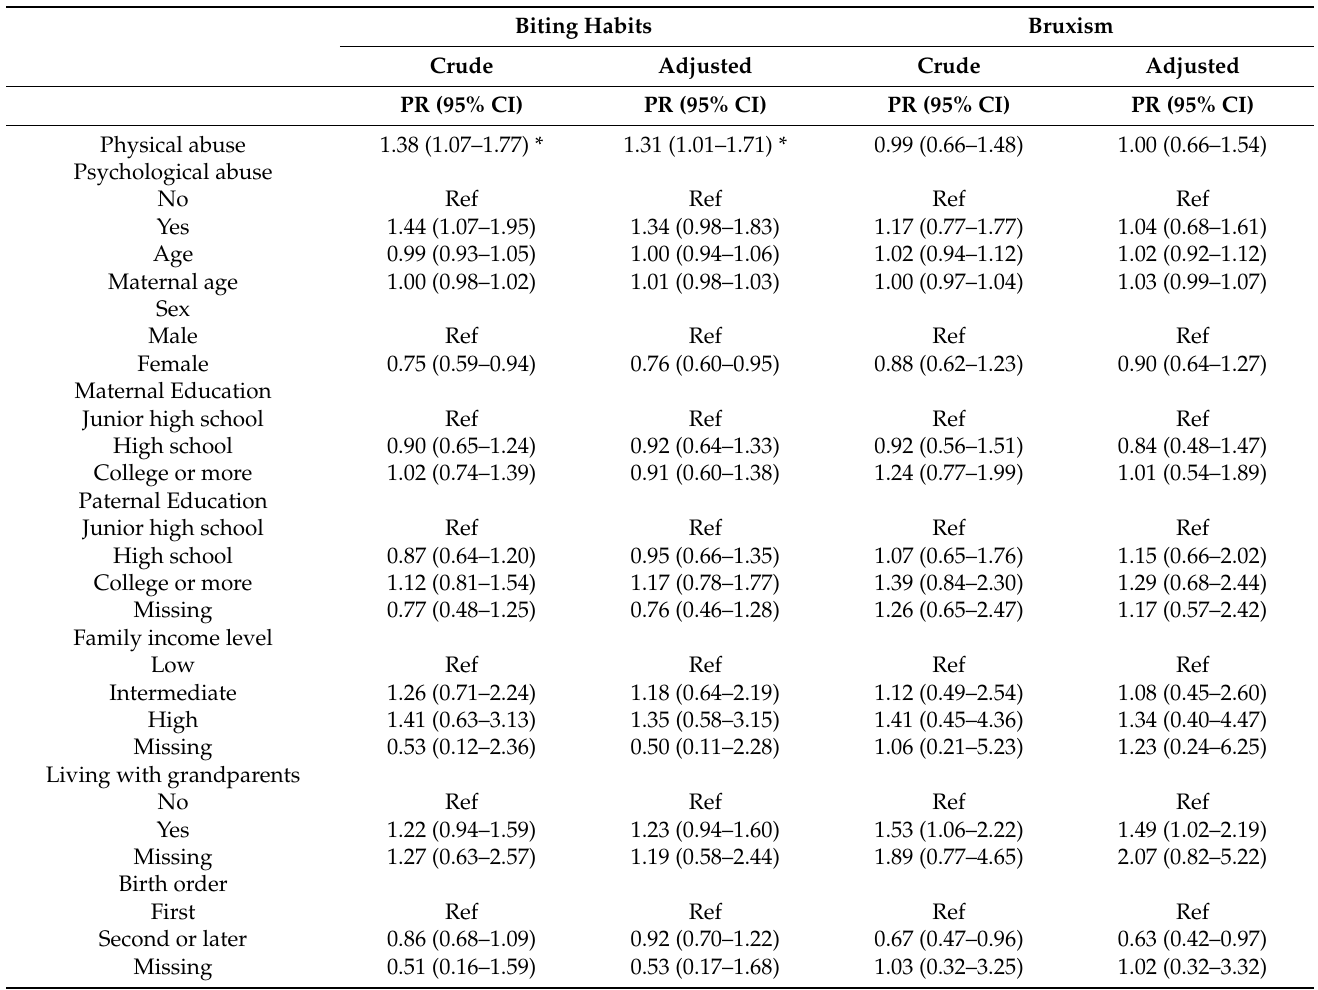
Table 2. Associations between physical abuse and oral habits (N = 761 a ). Biting Habits Bruxism